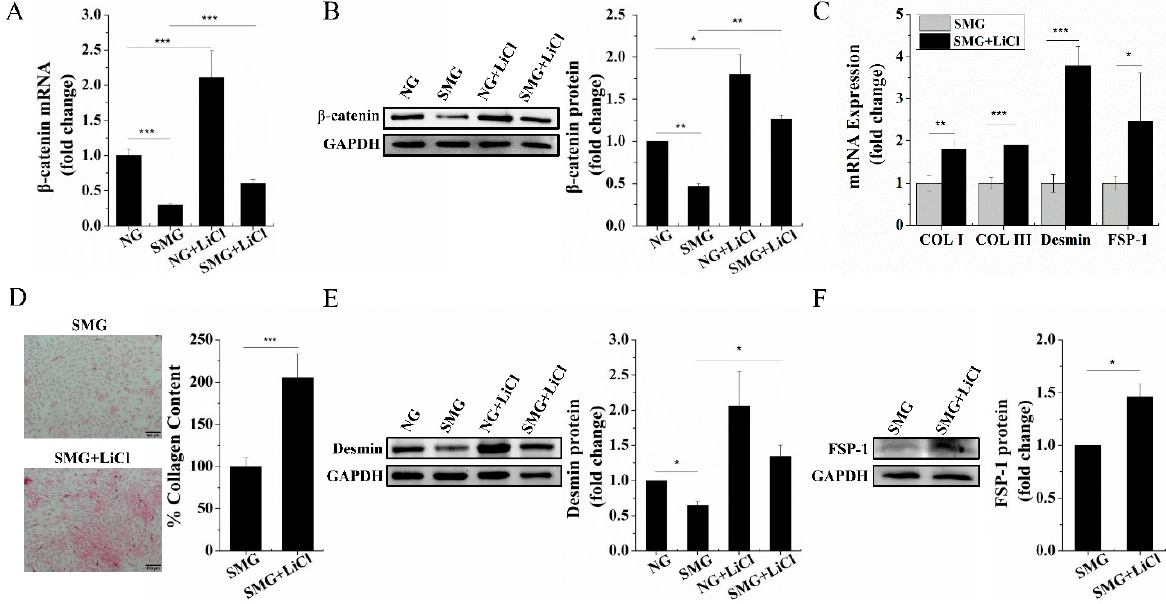
Figure 4. The role of Wnt/ β -catenin signaling in the differentiation of BMSCs into dermal fibroblasts under SMG conditions. ( A ) mRNA expression of β -catenin in SMG, SMG + LiCl, NG, NG + LiCl by RT-qPCR detection. ( B ) Western blot detection of β -catenin protein level in SMG, SMG + LiCl, NG, NG + LiCl. ( C ) mRNA expression of Col I, Col III, Desmin, and FSP-1 after LiCl treatment under SMG conditions by RT-qPCR detection. ( D ) Sirius red staining for Col I and Col III deposition evaluation in BMSCs and quantification data of Sirius red staining after LiCl treatment under SMG conditions. (scale bar, 100 µm). ( E ) Western blot detection of the Desmin protein level in SMG, SMG + LiCl, NG, NG + LiCl. ( F ) Western blot detection of the FSP-1 protein level after LiCl treatment under SMG conditions. BMSCs: bone marrow-derived mesenchymal stem cells; NG: normal gravity; SMG: simulated microgravity; Col I: collagen I; Col III: collagen III; FSP-1: fibroblast-specific protein-1; GAPDH: glyceraldehyde-3-phosphate dehydrogenase; LiCl: lithium chloride. Data are presented as mean with SD; n = 3, * p < 0.05; ** p < 0.01; *** p < 0.001.